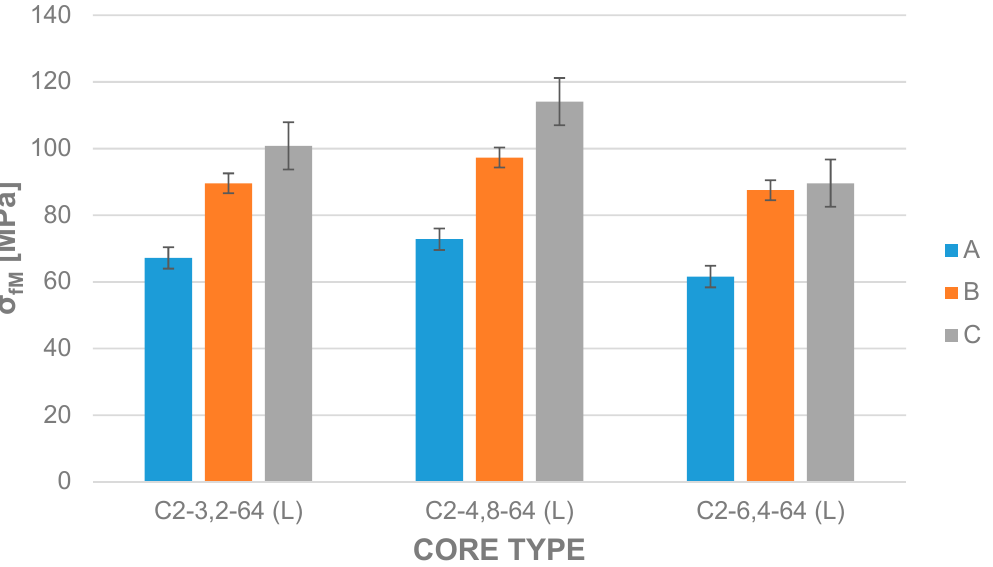
Figure 11. Influence of honeycomb geometry with mesh size (3.2, 4.8, and 6.4) mm on the bending strength of sandwich constructions A–C.